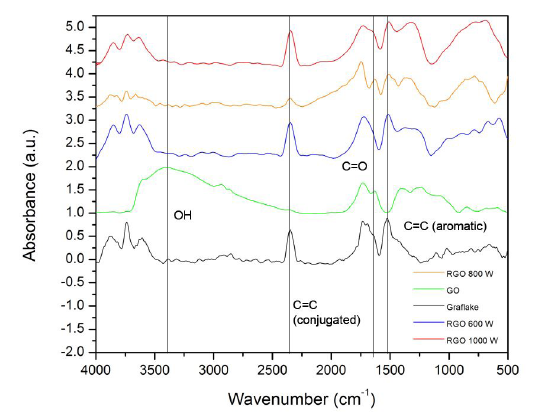
Figure 3. FTIR spectra of the RGOs were obtained at different powers.